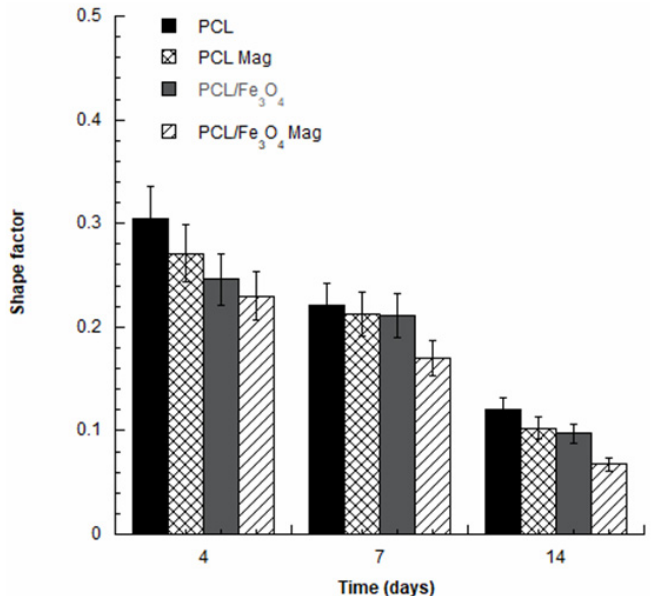
Figure 6. Shape factor evaluated from the CLSM images of human mesenchymal stem cells (hMSCs) on PCL and PCL/Fe 3 O 4 substrates (with or without magnetic stimulation) at different time points.